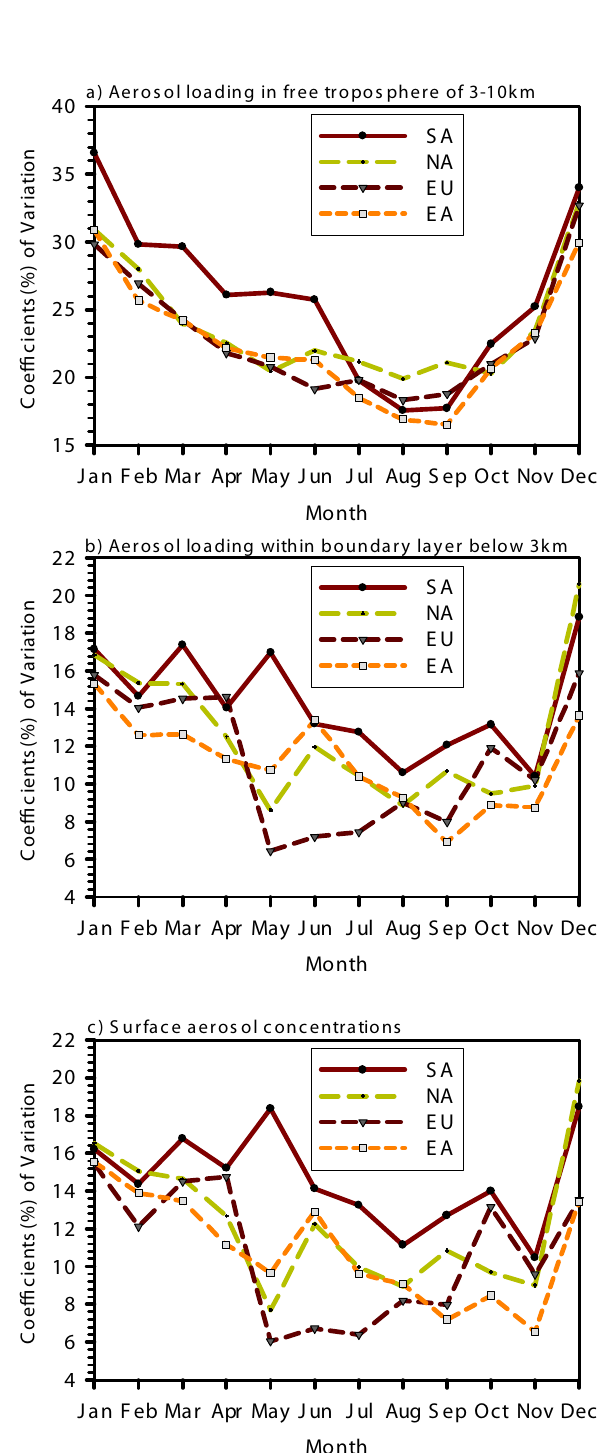
Fig. 8. Monthly CV(coefficients of variations) in the anthropogenic aerosol loading (a) in the free troposphere of 3–10km, (b) within the boundary layer below 3km and (c) the surface concentrations averaged in the SA-, NA-, EU- and EA-regions over